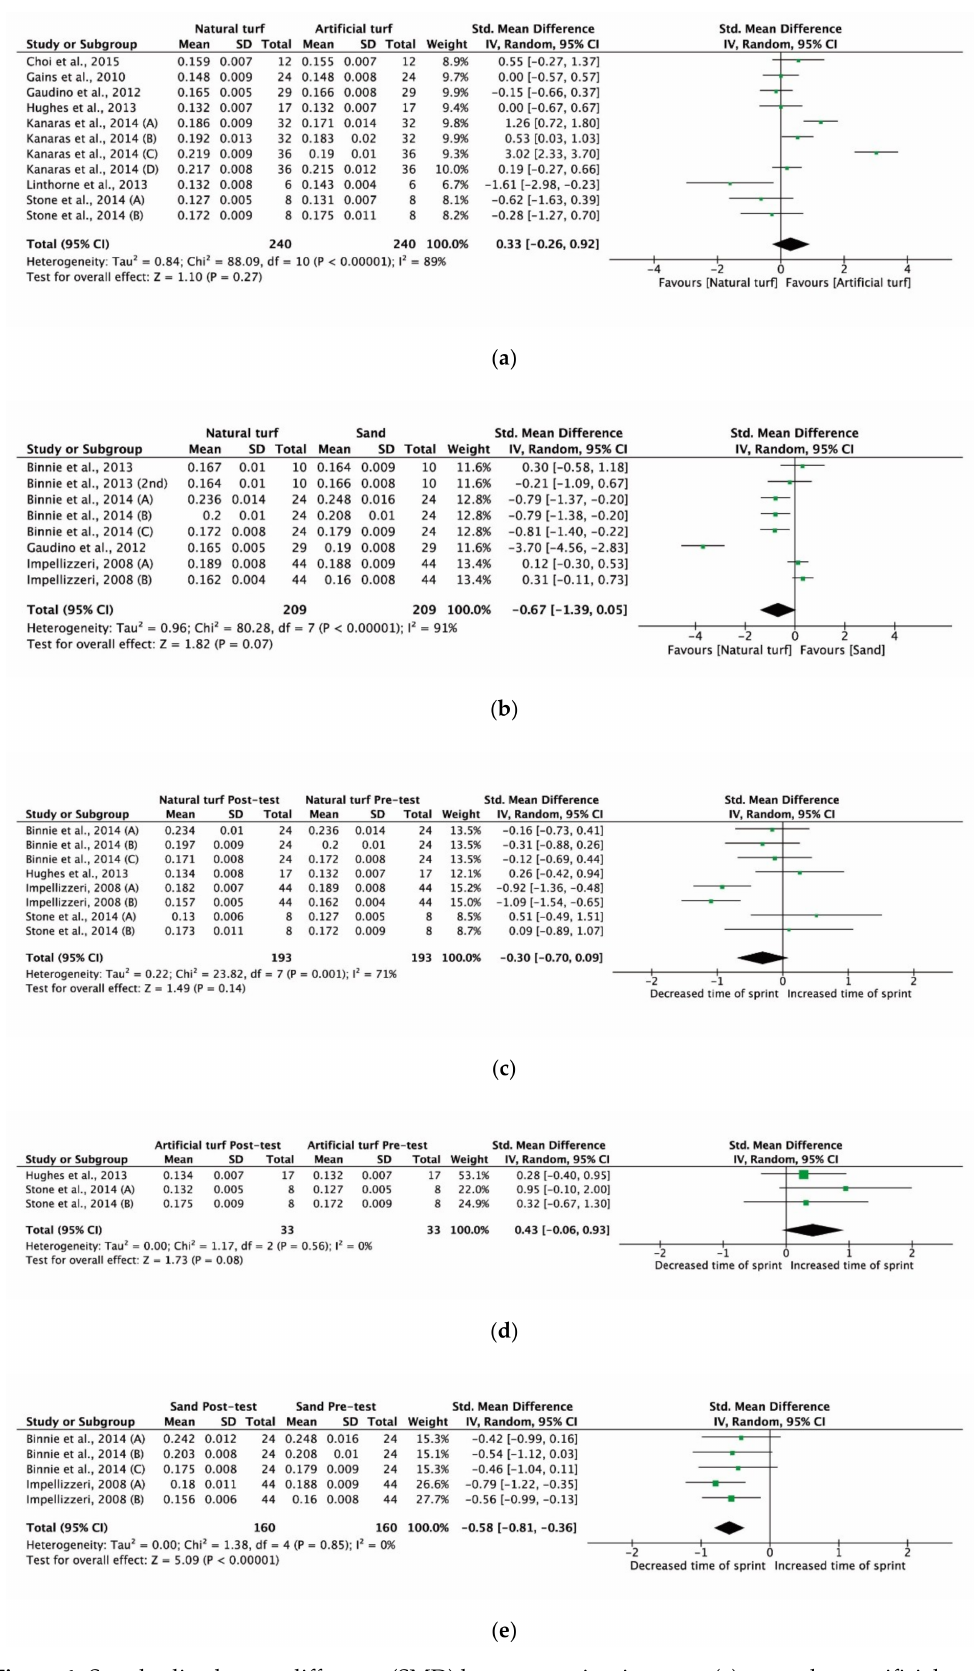
Figure 4. Standardized mean di ff erence (SMD) between sprint times on: ( a ) natural vs. artificial